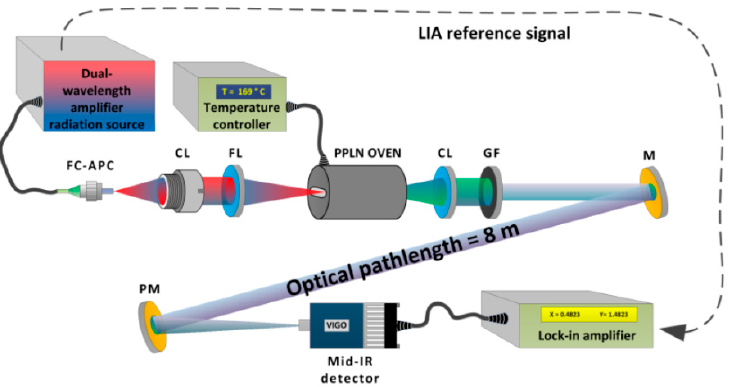
Figure 2. The methane detection system based on a dual-wavelength amplifier. Reproduced with permission from [91], Optical Society of America, 2013.